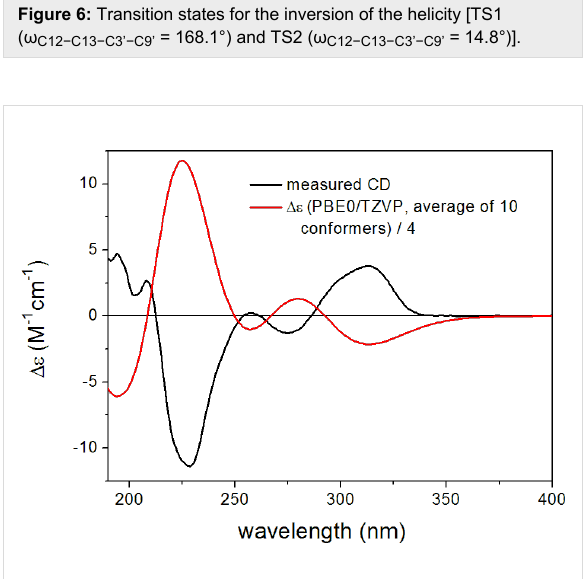
Figure 6: Transition states for the inversion of the helicity [TS1 ( ω C12 − C13 − C3’ − C9’ = 168.1°) and TS2 ( ω C12 − C13 − C3’ − C9’ = 14.8°)].